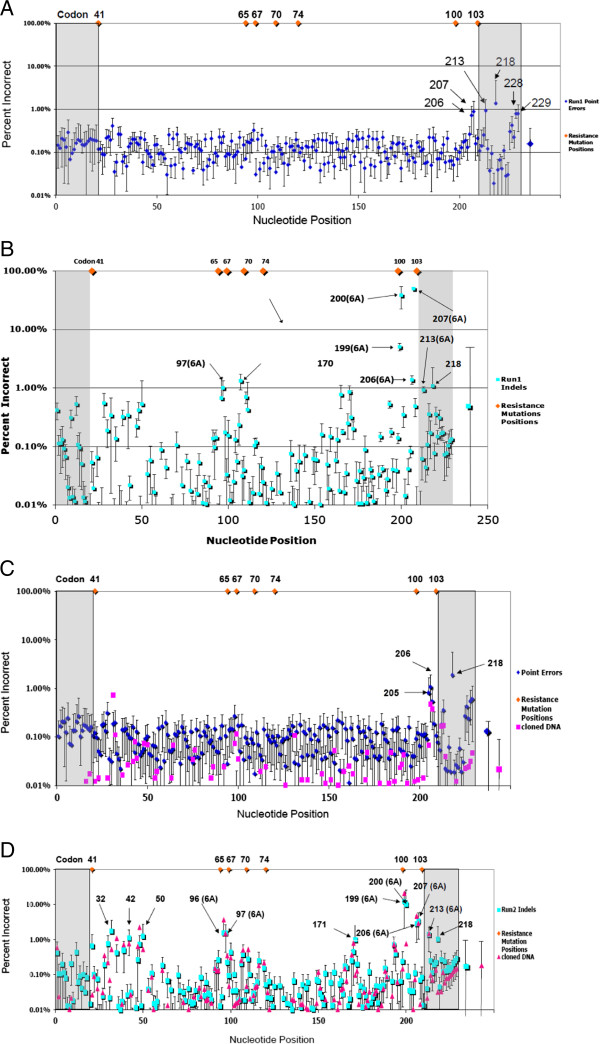
Point error and indel error estimation. (A). Point error distribution in Run1 fragment 1. The data are from Run1 MID1, 2, 5, 7, 8, and 9. The X axis is the nucleotide position of sequences, with position 1 corresponding to nucleotide 101 in BH10 RT
[29]. The Y axis is the mean error rate of all samples at each position (blue diamonds). The error bars correspond to 1 standard deviation. The orange diamonds at the top show the locations of drug resistance sites. The numbers with arrows indicate nucleotide positions of sites with high error rates. The gray boxes show the 20 nucleotide PCR primer regions. (B) Indel error distribution in Run1 fragment 1, combined MID1, 2, 5, 7, 8, and 9. The Y axis is the mean indel error rate of all samples at each position (blue squares). The error bars correspond to 1 standard deviation of the error rate of each position. Other symbols are as in panel A. The numbers in parentheses indicate the number of As in homopolymer regions. (C) Point error distribution in Run2 fragment 1. The data are from Run2 MID1, 5, 7, and 9. Conventions are as in panel A. The pink squares show point errors from cloned sample DNA (MID2). Blue diamonds show the mean error rate of all other samples at each position. (D) Indel error distribution from Run2 MID1, 5, 7, and 9. Conventions as in panel B Pink squares show the indel errors of cloned sample DNA. Blue squares are the mean indel error rate of all other samples at each position. The colored symbols and vertical lines after the second gray box show the average errors and standard deviations.